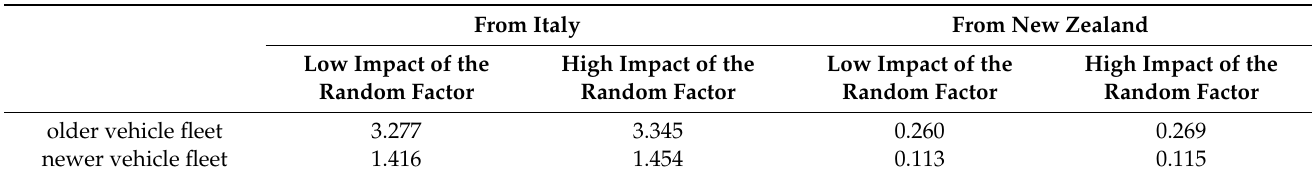
Table 5. CO 2 emission values per kilometre of the supply chain for analysed scenarios for clothes suppliers.